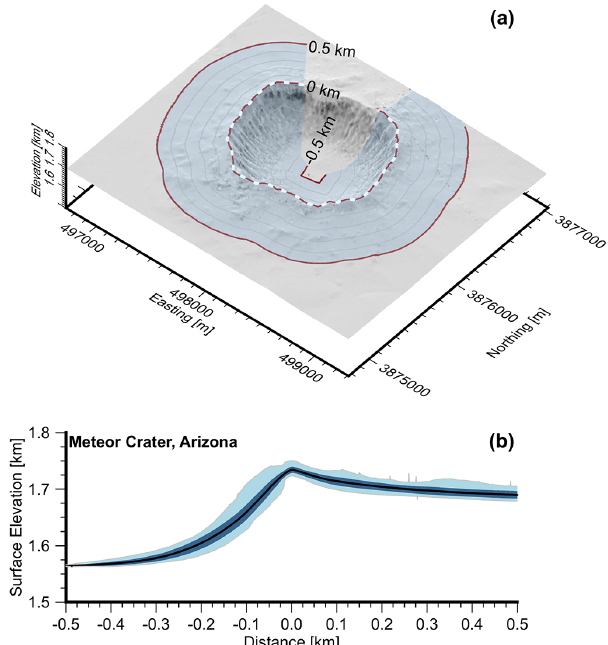
Figure 6. Generalized swath profile analysis of Meteor Crater (Ari- zona). The baseline (white and red dashed line) follows the crater rim, and contours indicate the signed distance to the baseline. The blue transparent region covers all values included in the profile. Mean elevation, (thick black line), extreme values (hull of the blue area), and mean elevation ± 1 standard deviation (hull of the dark area) are shown. Bin width is 1m. The map and the profile are based on the lidar point cloud processed by the National Center for Air- borne Laser Mapping (http: // www.ncalm.org) and interpolated onto a regular Cartesian grid (UTM coordinate system) with a spatial resolution of